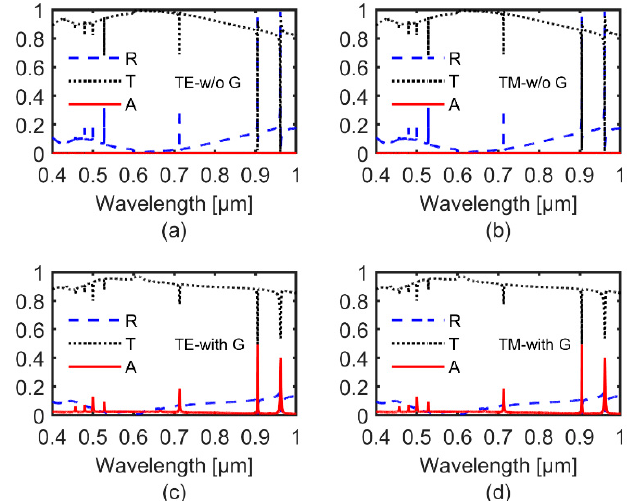
Figure 2. Optical reflectance (dashed blue line), the transmittance (dotted black line), and absorption (solid red line) spectra ( a , b ) without and ( c , d ) with graphene layer for both ( a , c ) TE and ( b , d ) TM plane waves at normal incidence. The device period p, waveguide Ta 2 O 5 thickness t Ta2O5 , and PMMA pillars height t PMMA for this simulation result are set as 600 nm, 150 nm, and 600 nm, respectively.